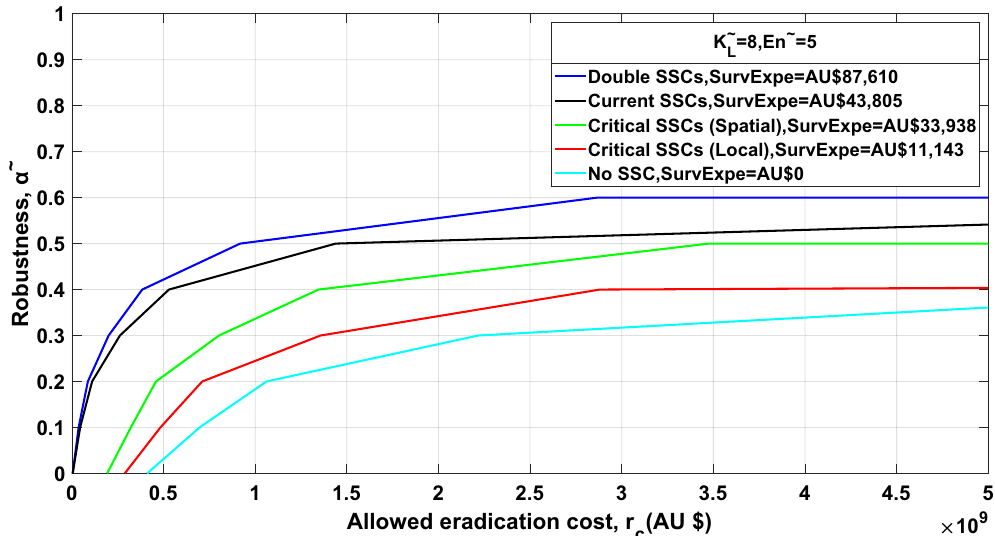
Figure 4. Robustness curves for situations shown in the legend. In each situation, the population threshold for detection of Asian house gecko at each location is estimated at 8 (i.e. ˜ K L = 8 for L = 1, . . . , 6 ) and the annual number of entries of AHG individuals after border inspection to any of the locations on Barrow Island is estimated at 5 ( ˜ En = 5 ). All lines, except for the red line (based on local spread model), are based on spatial spread model. The optimal allocation of Surveillance System Components (SSCs) in each zone at each location is denoted as ‘Optimal Spatial’. The application of double (200%) and no SSCs in each zone at each location is denoted as ‘Doubling Optimal Spatial’ and ‘No SSCs Spatial’ separately. The ‘Critical Spatial’ and ‘Critical Local’ are applied to meet Chevron’s ministerial requirements. The ‘SurvExpe’ indicates the corresponding estimated surveillance cost in each